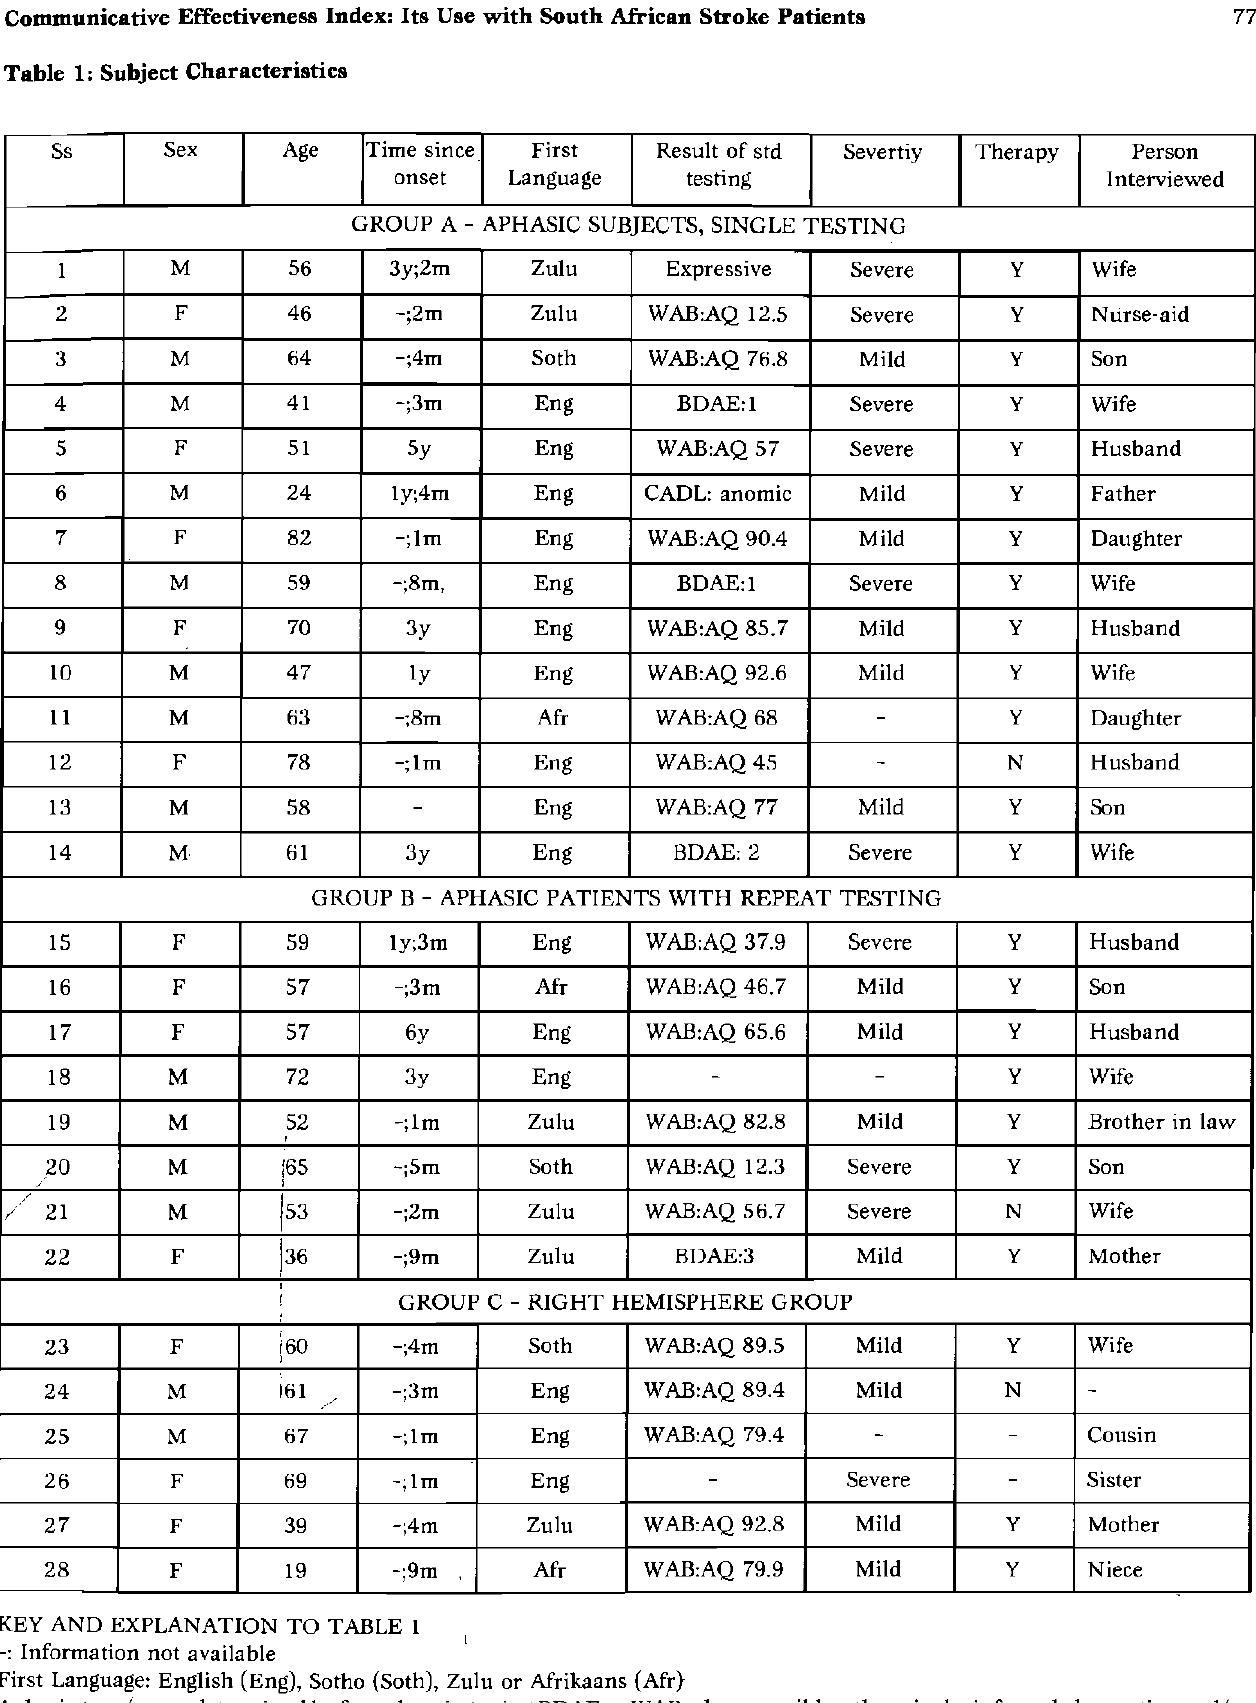
Table 1: Subject Characteristics